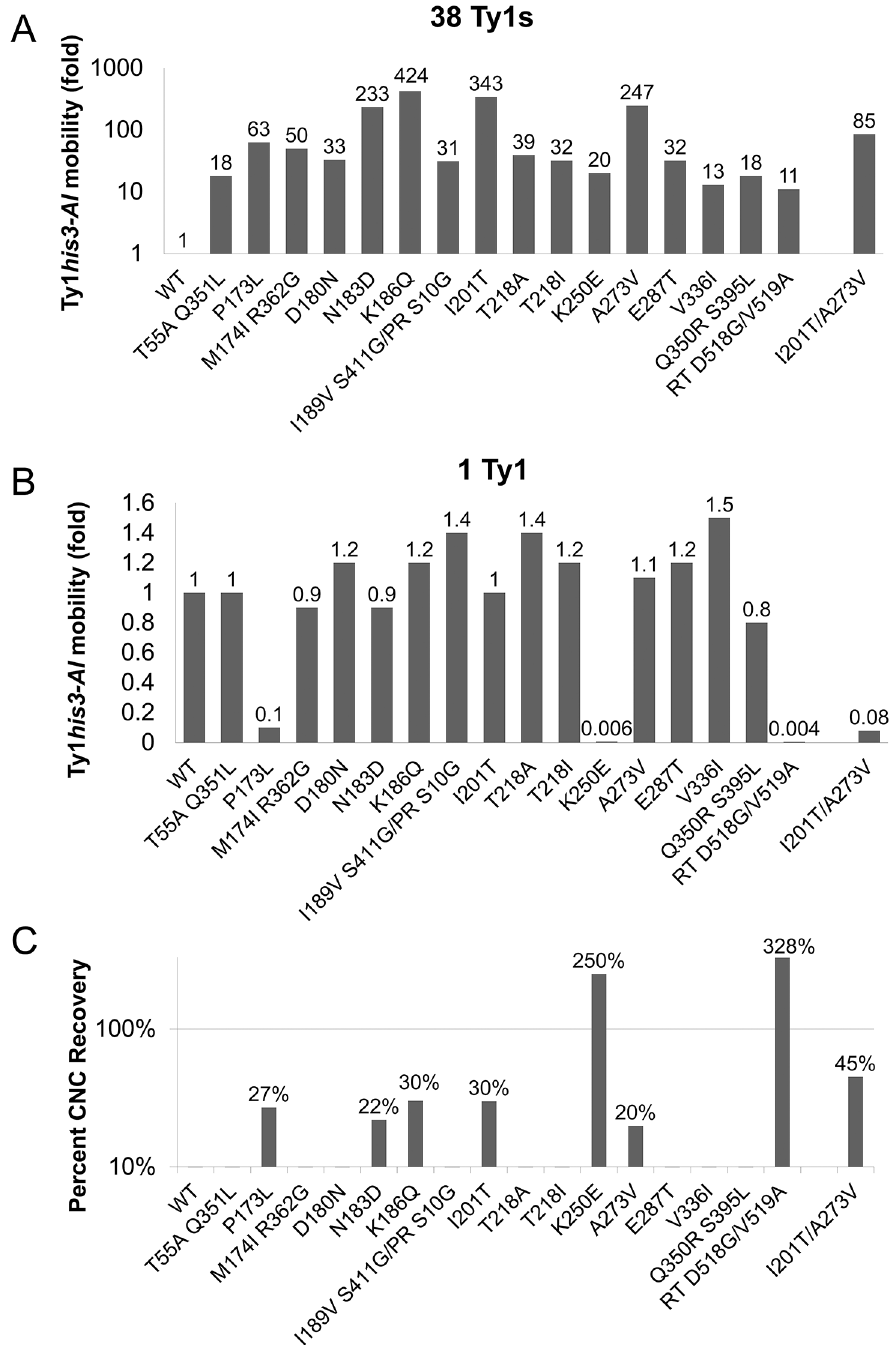
Fig 2. Ty1 GAG mutations are specific and partially resistant to CNC. S . paradoxus repopulated with 38 (YEM515; A) or 1 (YEM514; B) genomic copies of Ty1-H3 and containing wild type or CNC R pGTy1 his3-AI plasmids were analyzed for Ty1 his3-AI mobility. Ty1 his3-AI mobility for each mutant was normalized to wild type and fold changes are represented. Raw data can be found in S4 Table. (C) Percent CNC recovery was calculated by dividing Ty1 his3-AI mobility in the 38 Ty1 copy strain by mobility in the 1 copy strain. Recoveries above 10% are